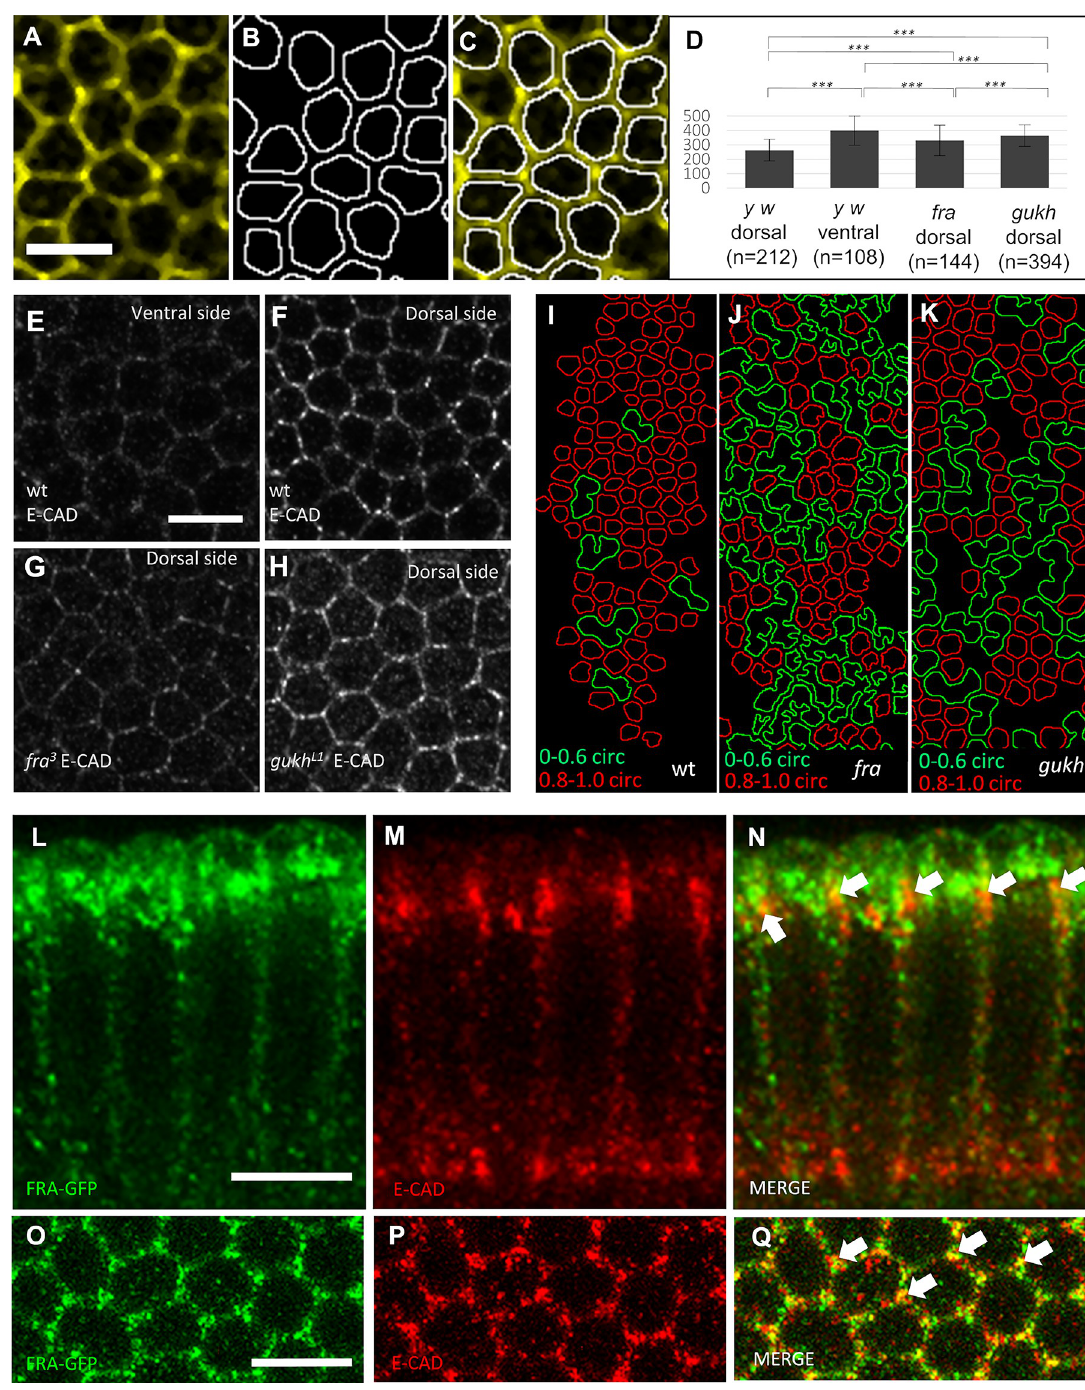
Fig 4. FRA and GUKH are required for cell constriction through apical localization of E-CAD at cell membranes. (A–C) Image segmentation for cell surface measurements. (A) Filtered image of anti-E-CAD staining. (B) Image segmentation shows outlines of membranes bordering E-CAD. (C) Merge of A, B. (D) Quantifications of surface areas from wild-type ventral and dorsal cells, and dorsal cells from fra and gukh mutant at late cellularization stage. In the wild type, dorsal cells are significantly smaller than ventral cells. In fra and gukh , dorsal cells are not constricted as dorsal cells in wild type. Error bars, standard deviation; p -values calculated with two- tail Mann–Whitney test ( ��� p < 0.001). (E, F) Late-stage wild-type embryo stained for anti-E-CAD showing lower levels in ventral (E) than dorsal cells (F). Dorsal cells from fra (G) and gukh (H) stained for E-CAD. Note larger cell sizes with diffuse E-CAD signal compared to wild type, and low E-CAD membrane signal in fra (see also S3 Fig). (I–K) Segmented dorsal cells from wild type, fra